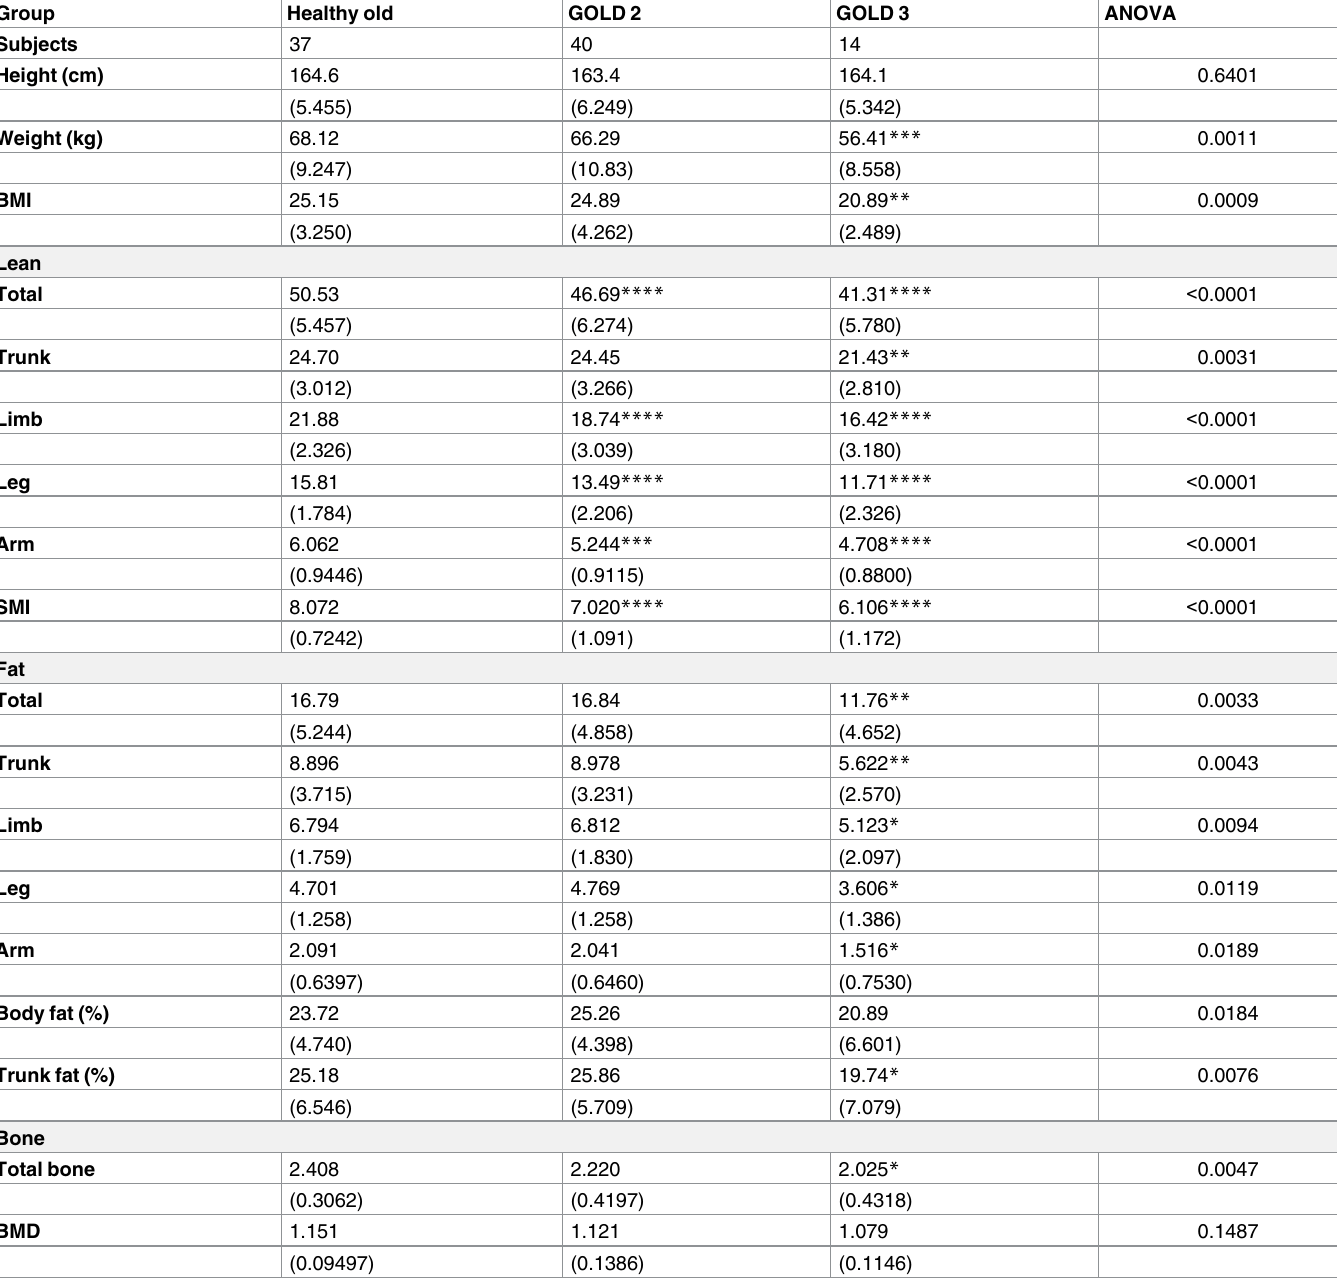
Table 2. Differencesbetween older subjects with and without chronic obstructive pulmonary